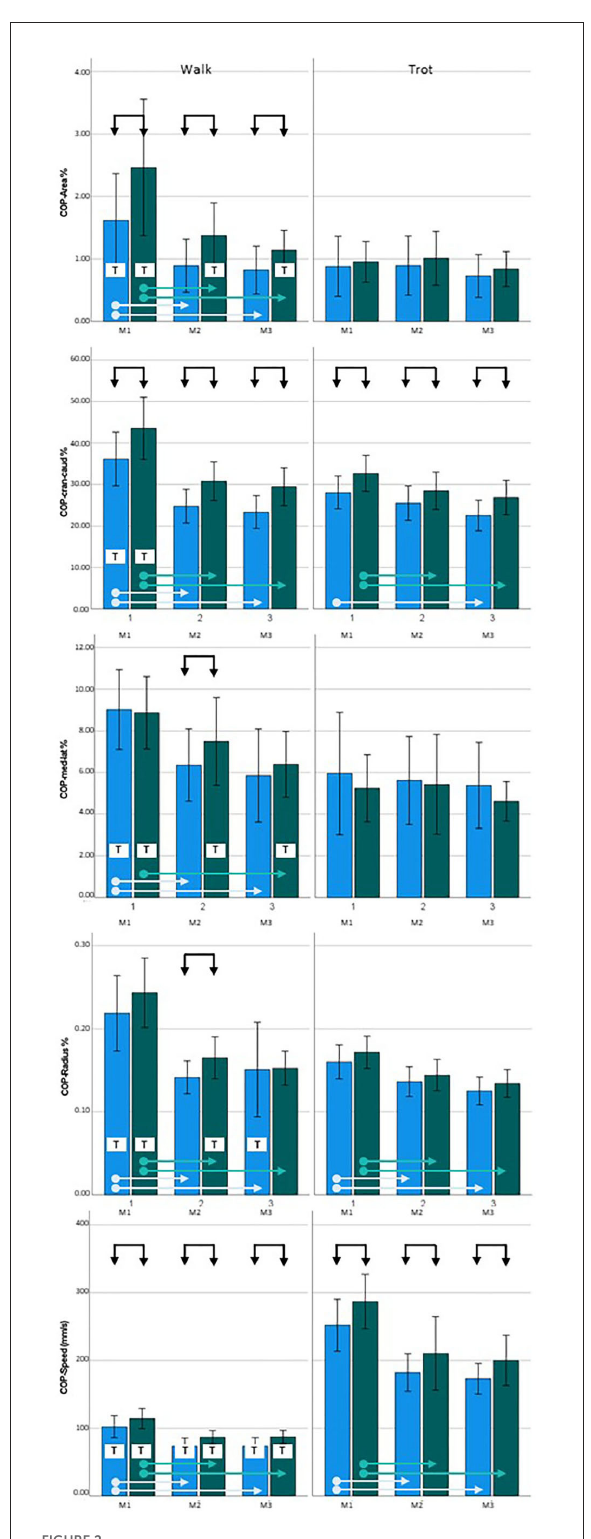
FIGURE2 Center of pressure (COP) data for Golden Retrievers. Left = walking, right = trotting; blue = soundlimbs, green =